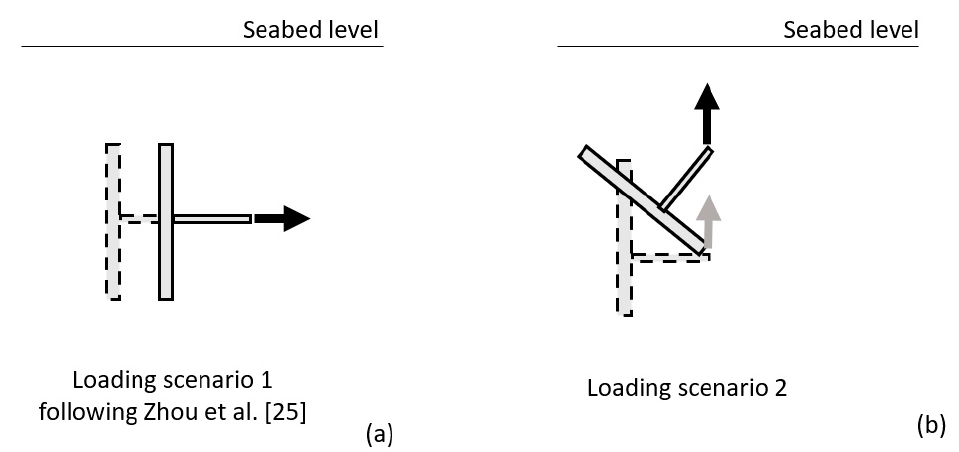
Figure 8. Loading scenarios for the cyclic loading of a plate